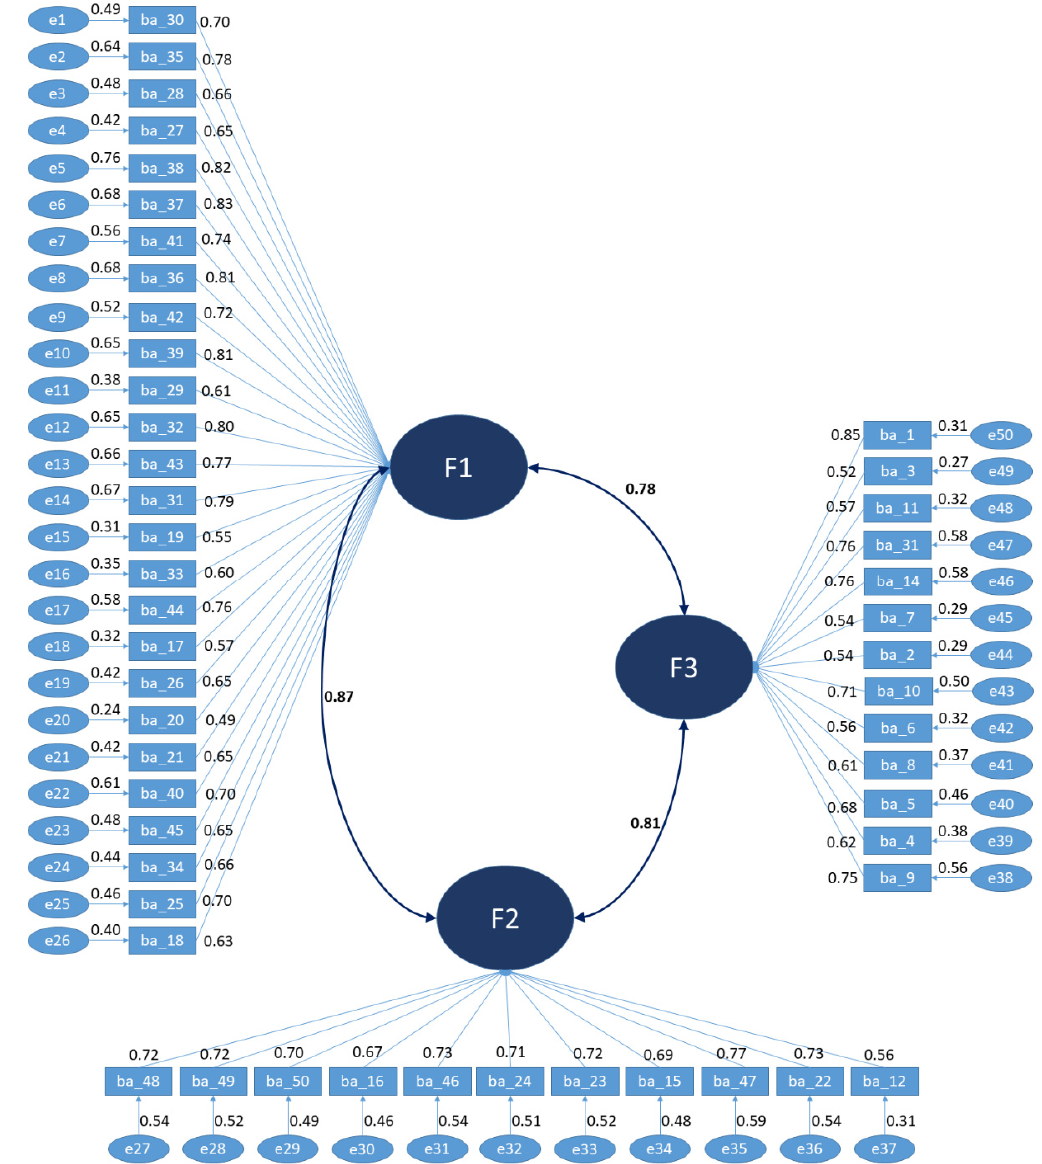
Figure 3. Initial model hypothesized with three factors (A high-resolution version is available in the Supplementary Materials—Figure